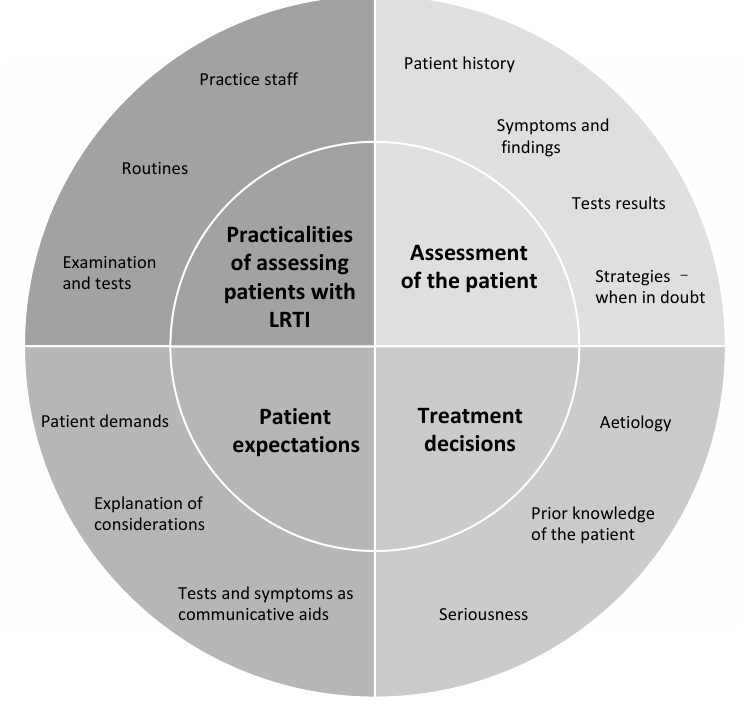
Figure 1. Overview of the analytic themes and the components within each